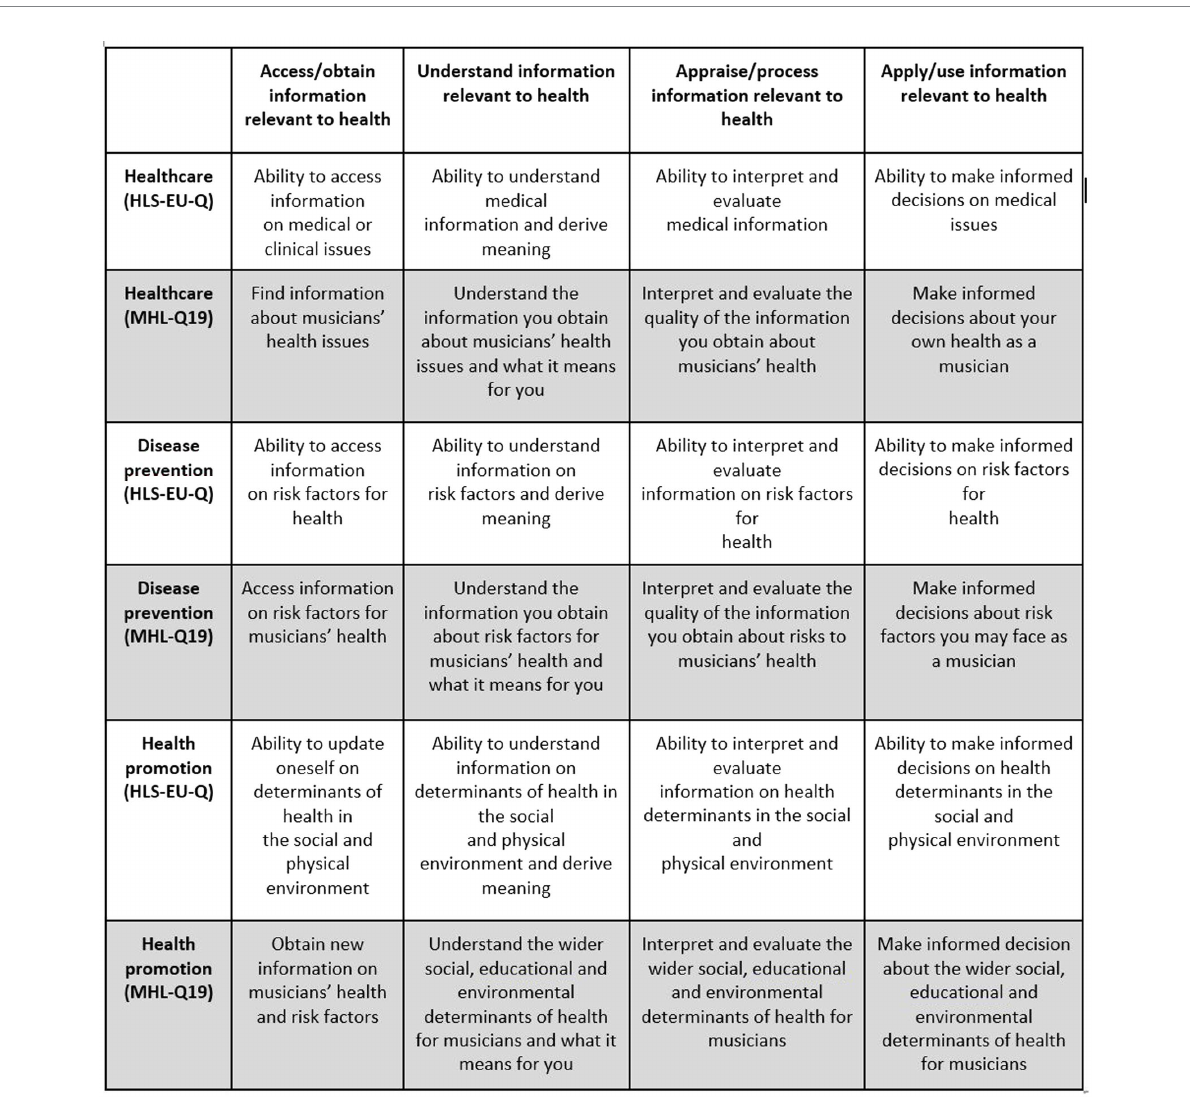
FIGURE 1 Four dimensions of health literacy across three domains of health: original HLS-EU health literacy matrix (Sørensen et al., 2012; used with permission) and adapted MHL-Q19 matrix (Wijsman et al., forthcoming; see footnote